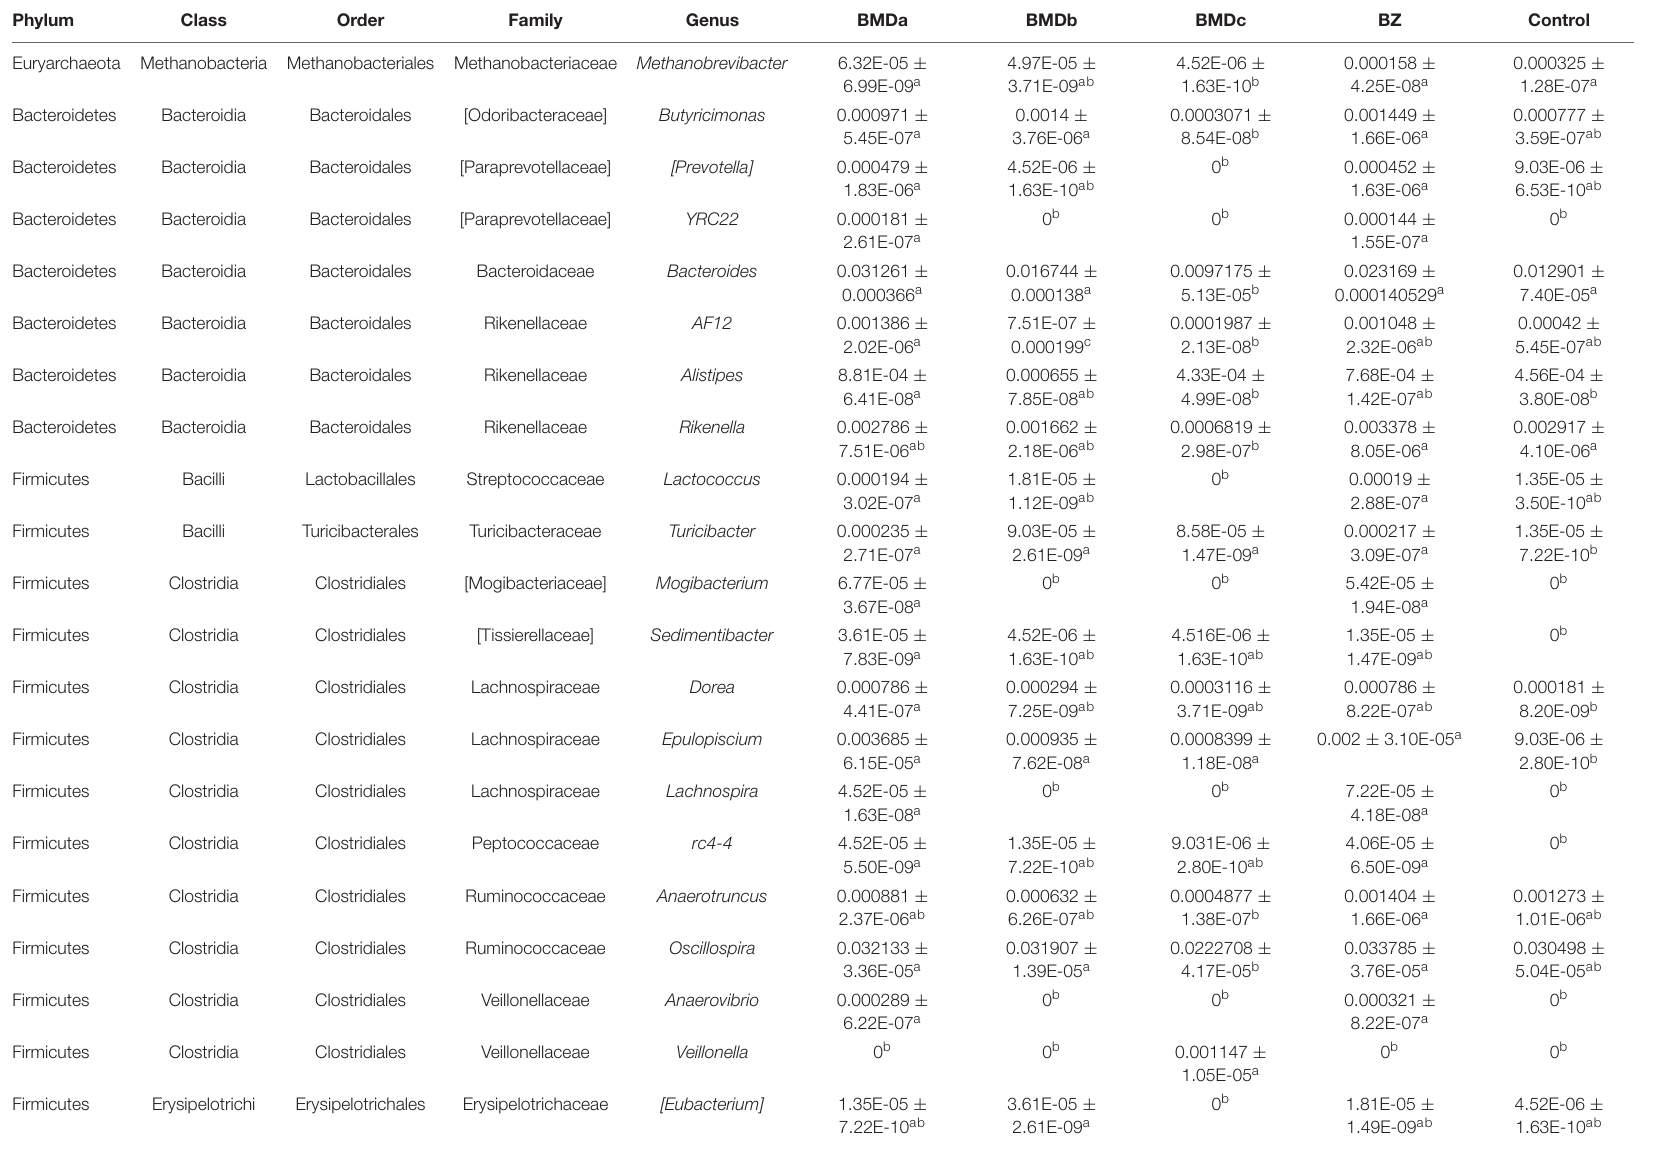
TABLE 4 | Effect of BMD supplementation on the relative abundance of bacterial genera in the cecal content detected using 16S rRNA sequencing.